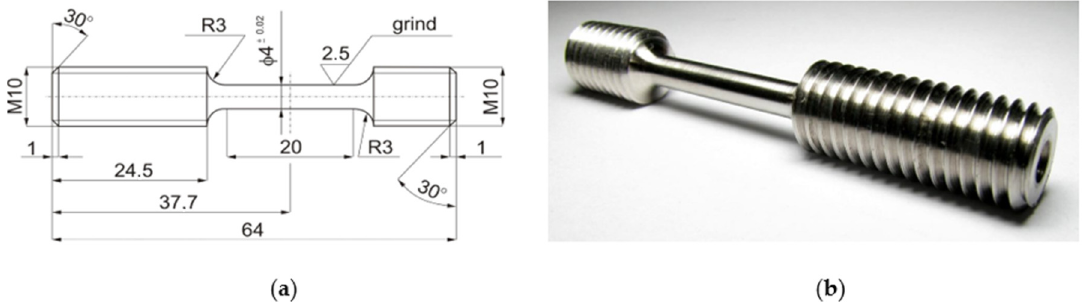
Figure 6. The smooth cylindrical sample (metric unit) for the dynamic tensile test stand for dynamic tests ( a ); the workspace of the flywheel machine ( b ), where R3 is radius 3mm, M10 is diameter